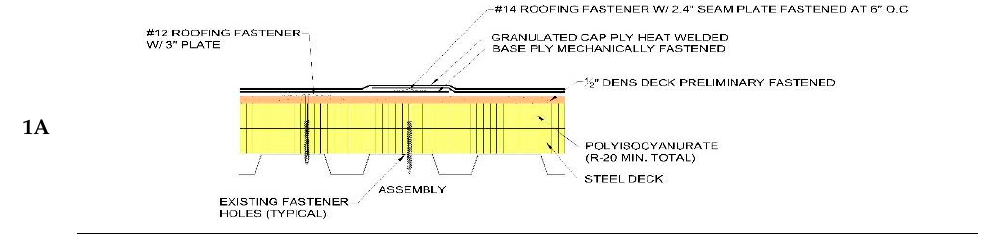
Table 1. Description of roofing assemblies analyzed in this study. (Refer Appendix B).